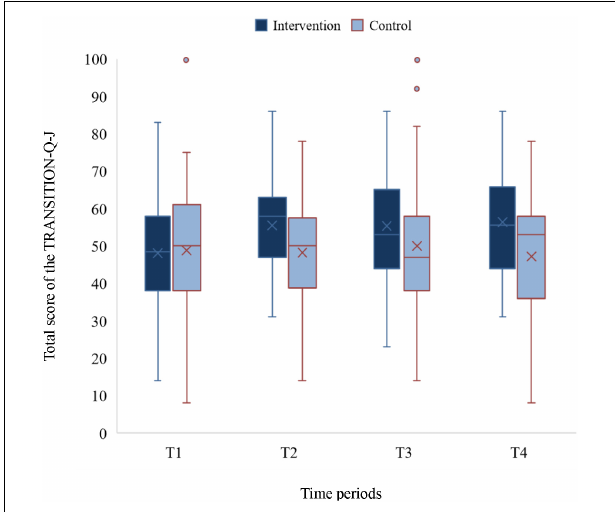
FIGURE 2 | A box plot of the score